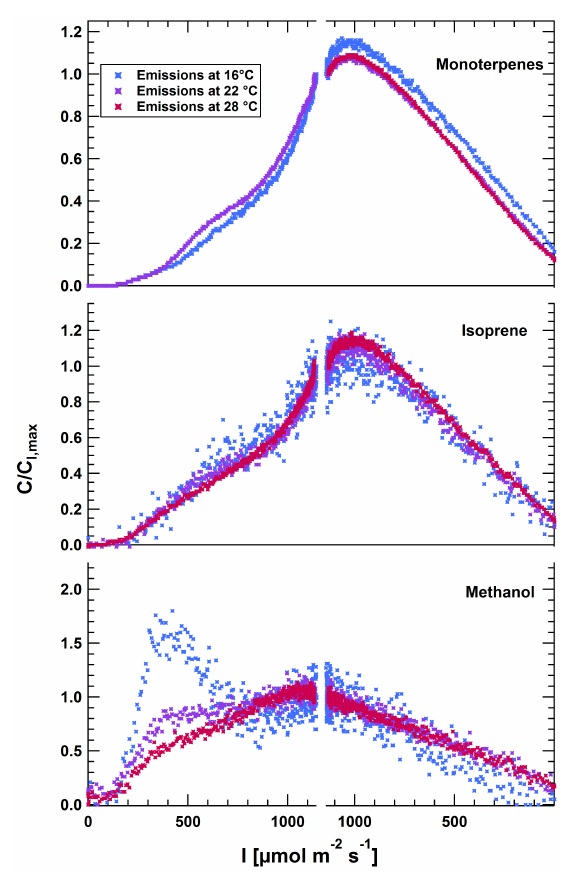
Figure 7. Light-dependent emissions of Quercus ilex under differ- ent air temperature conditions, with C I, max referring to observed concentrations at maximum light intensity ( I ) (upward